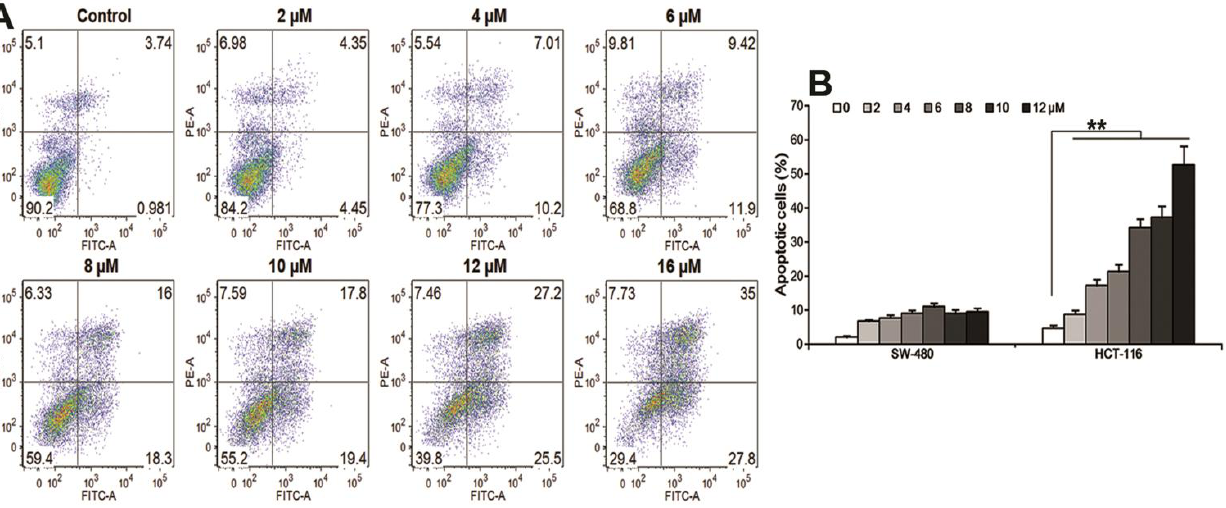
Figure 4. Oplopantriol A (OPT A) induces apoptosis in HCT-116 and SW-480 cells. ( A ) OPT A significantly induces apoptosis in HCT-116 cells in a concentration-related manner ( p < 0.01); ( B ) bar graph shows that OPT A more significantly induces apoptosis in HCT-116 cells than in SW-480 cells at 48 h (** p < 0.01). Data are presented as a percentage of total cells counted, calculated from three